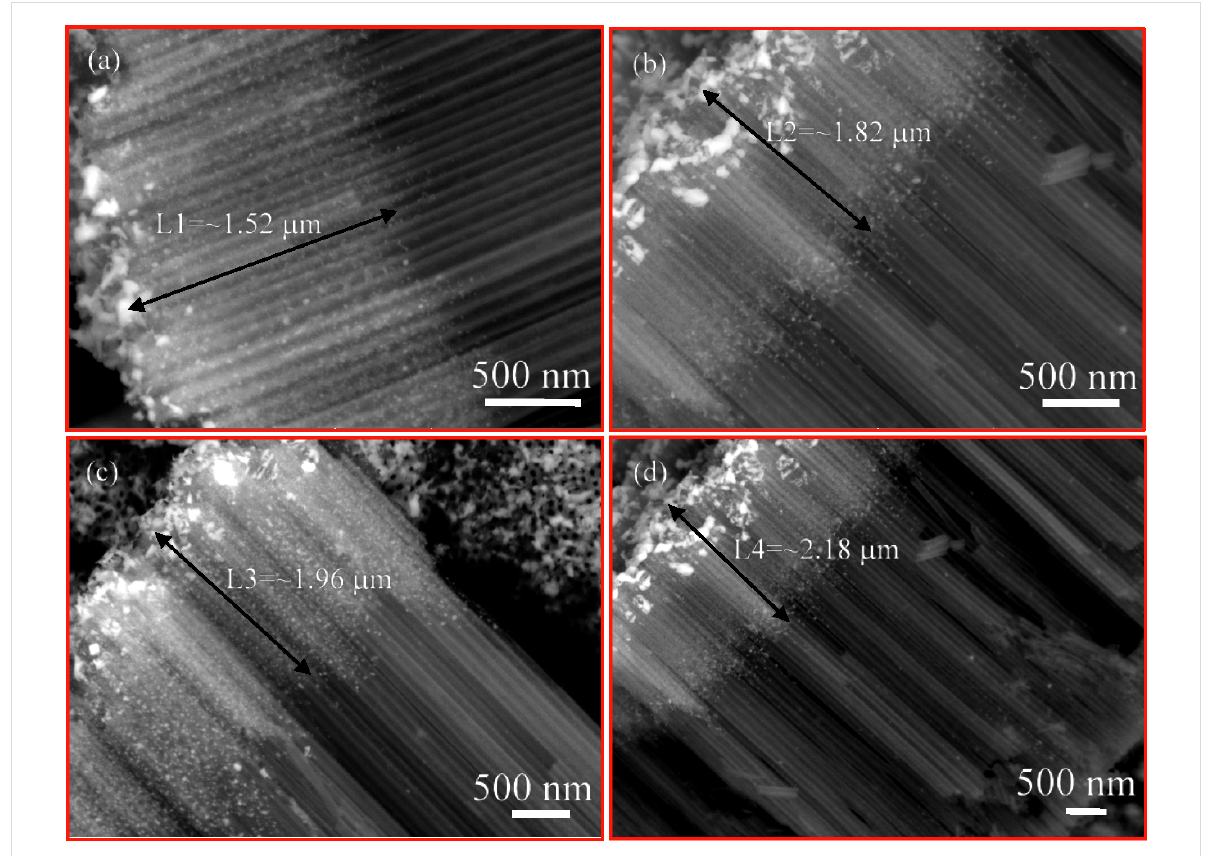
Figure 6: SEM images of the heat-treated TiO 2 nanotube arrays with Ag nanofilm at 400 °C for different periods of time: (a) 1 h, (b) 2 h, (c) 3 h, and (d) 4 h.